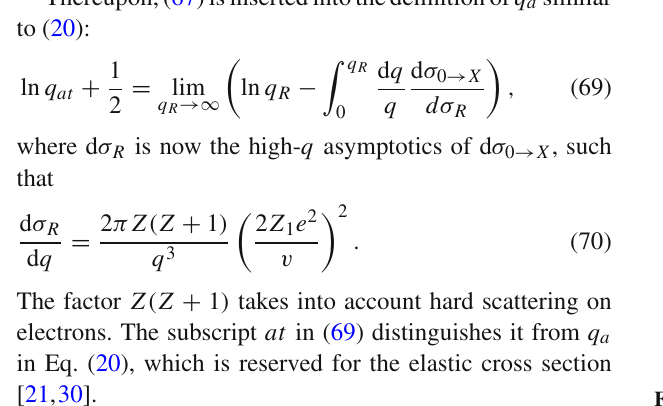
Fig. 4 A snapshot of an atom in the impact parameter plane, as seen by the fast projectile. Nonperturbative eikonal phases build up in the entireatomprojection(insidethedashedcircle),buttheircontributionto the integral defining Molière’s screening angle can be shrunk to vicini- ties of electrons and of the nucleus constituting the atom. Each of the nonoverlapping vicinities then gives an independent contribution to the Coulomb correction. Contributions of particles with different charges